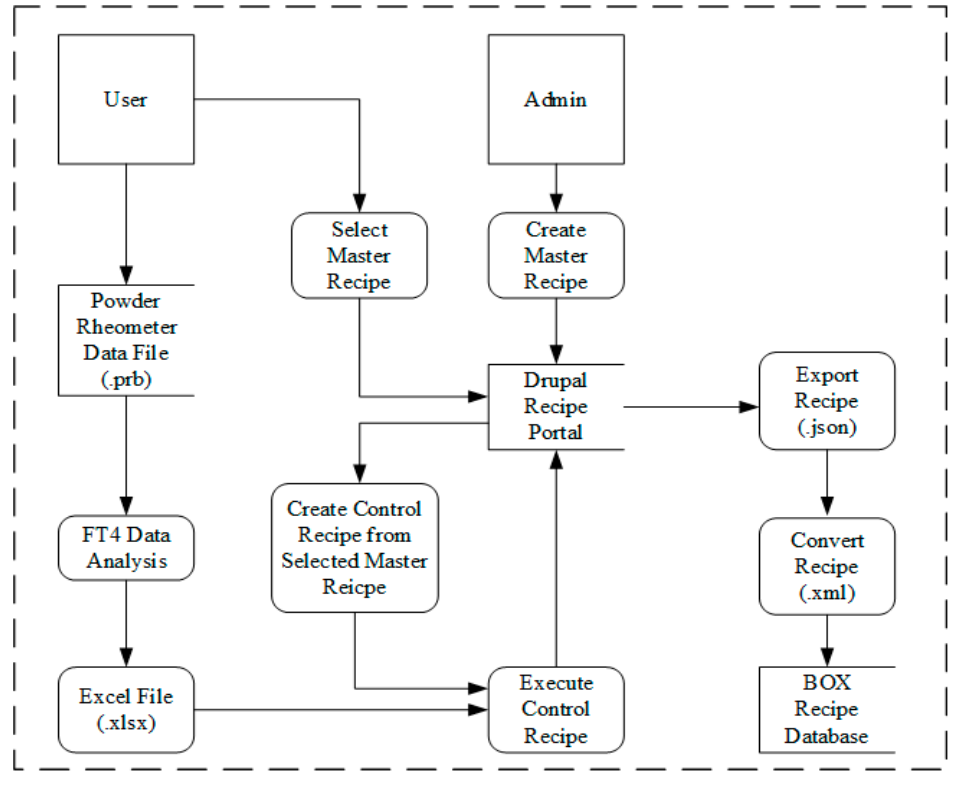
Figure 18. Data flow in performing FT4 experiment using the ELN system.